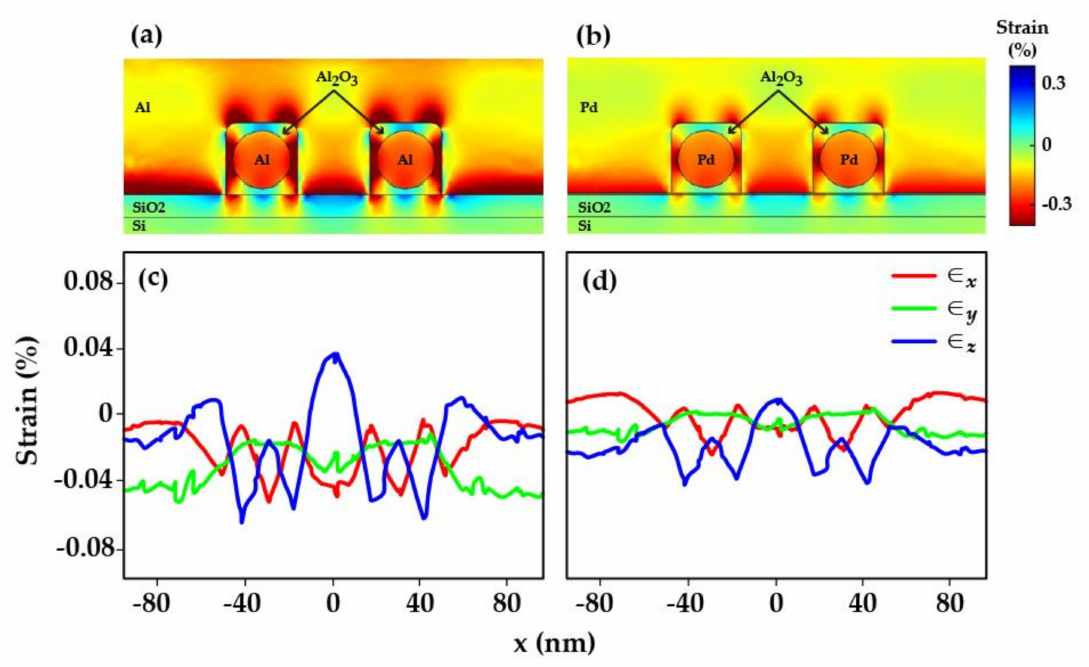
Figure 2. Simulated strain for Al and Pd gates on Si-bulk based on Figure 1a model at the SiO 2 thickness of 10 nm. ( a , b ) are the cross-section strain ∈ z cut at xz axis plane, while ( c , d ) are the strain components ∈ ∈ ∈ x , y and z at 1 nm below the Si–SiO 2 interface for Al gates and Pd gates, showing the e from CTE mismatch of Al–Al 2 O 3 and Pd–Al 2 O 3 ,